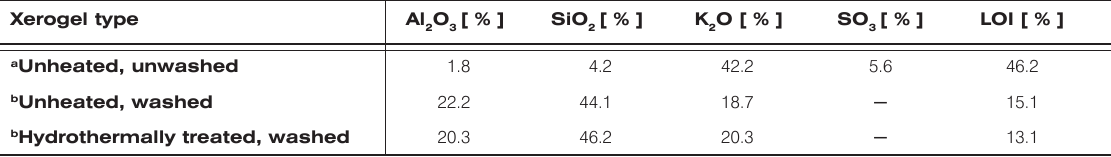
Table 1. Chemical compositions of xerogels, expressed as the weight percentage of element oxides and loss on ignition. Xerogel